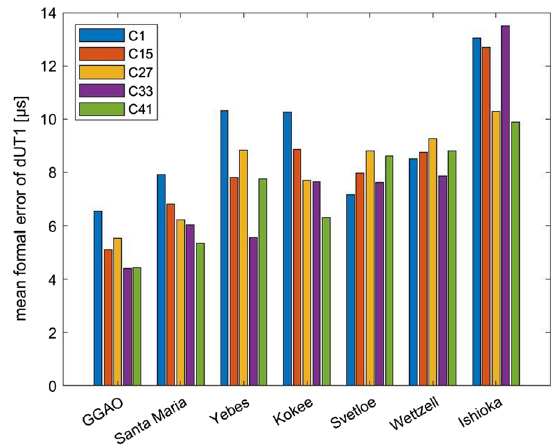
Fig. 10 Mean formal error of the intensives of five study locations paired with different VGOS stations shown in the x axis of the plot